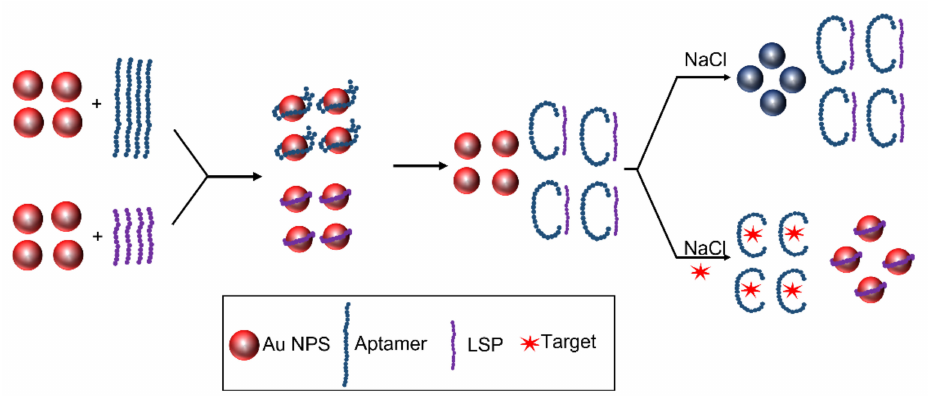
Figure 12. Schematic description of the chloramphenicol (CAP) detection based on colorimetric assay. In the absence of a target, the aptamer and LSP are coupled and a blue color as a result of the accumulation of AuNPs appears. In the presence of CAP, the aptamer and LSP are disassembled, and a red color is observed. Reprinted with permission from ref. [120]. Copyright 2018,